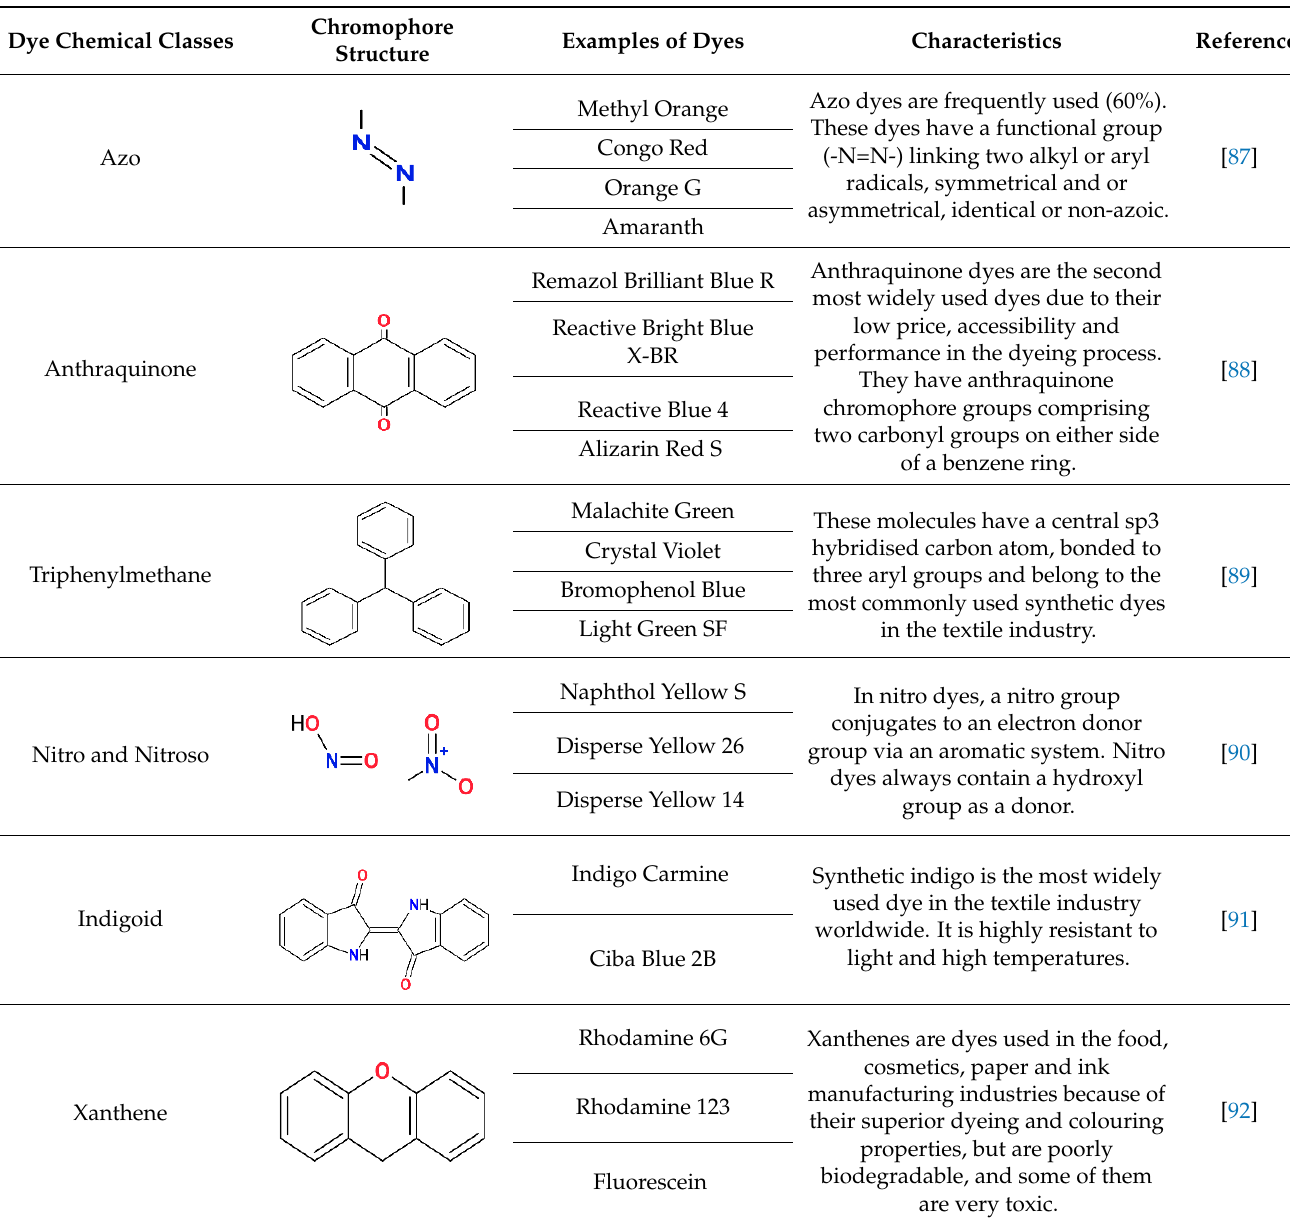
Table 1. Classification and characteristics of dyes depending on the structure of the chromophore.